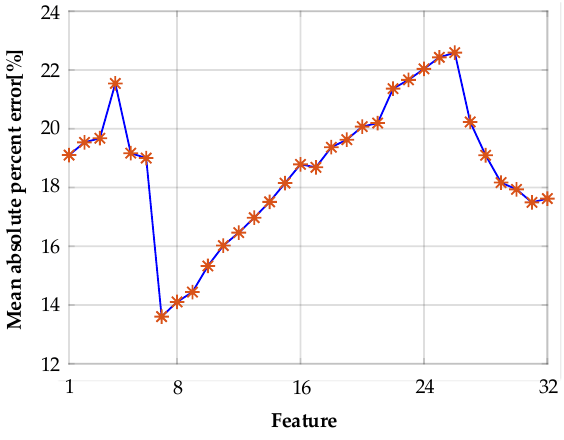
Figure 8. Relationship between prediction accuracy and number of features.